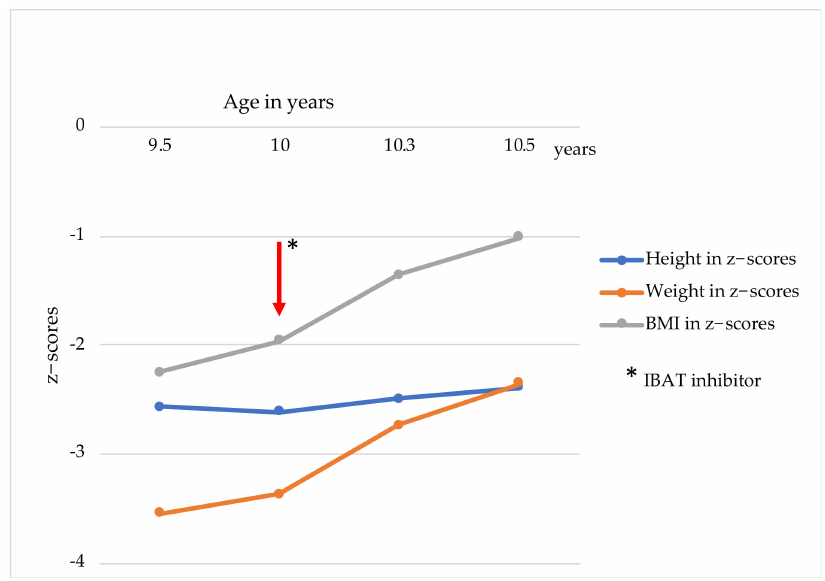
Figure 3. Weight, height, and BMI in z − scores before and with IBAT inhibitor. IBAT, ileal bile acid transporter inhibitor; BMI, body mass